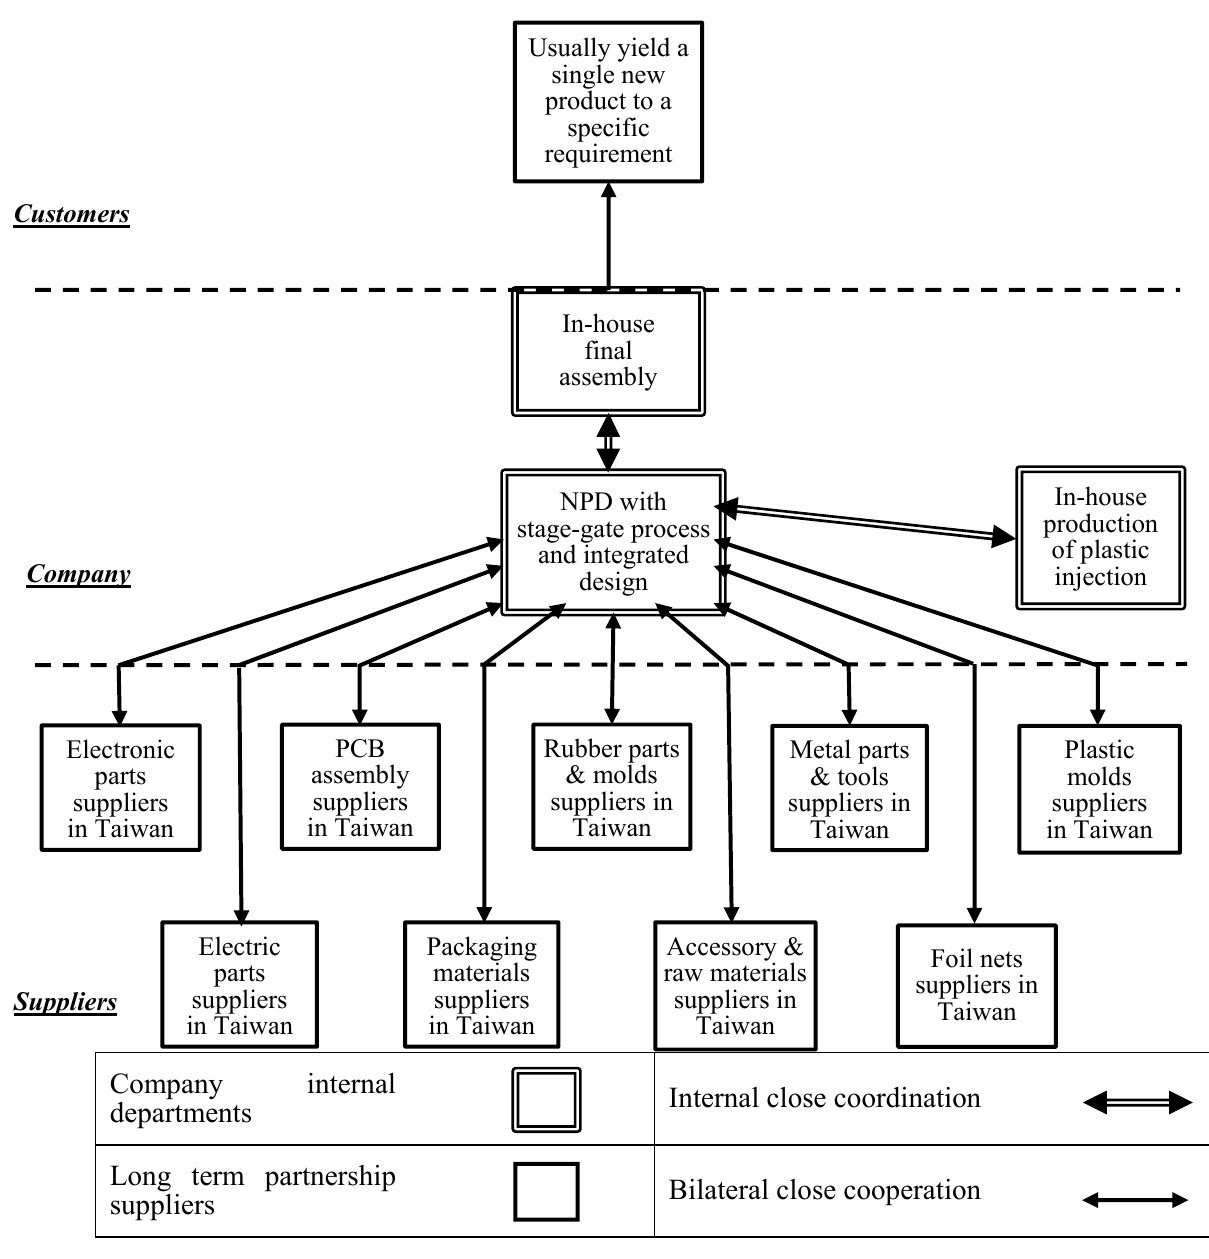
Figure 2. Case company’s original supply chains by early 2000.